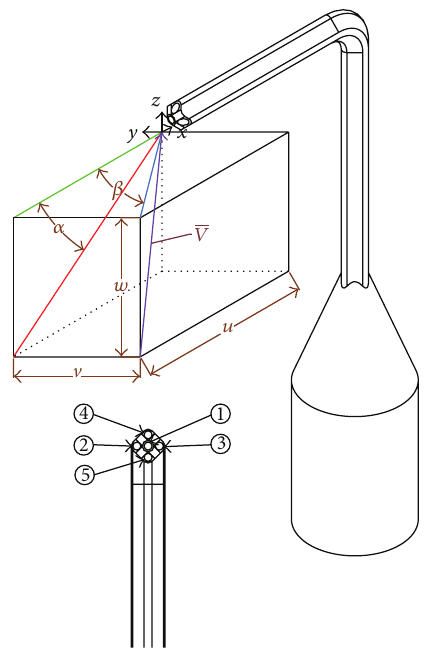
Figure 1: Isometric view of a subminiature Five-Hole Probe with velocity vector, positive angles, and positive velocity components and probe port number assignments.